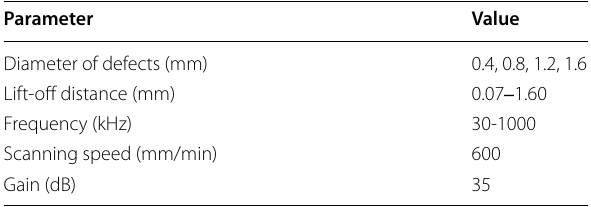
Table 2 Parameters adopted in the ECT experiments Parameter